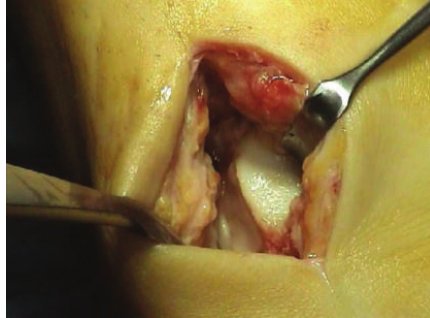
Figure 4: A small arthrotomy was necessary in 2 cases for the achievement of the lesion and the placement of the 3-dimensional matrix with cultured chondrocytes